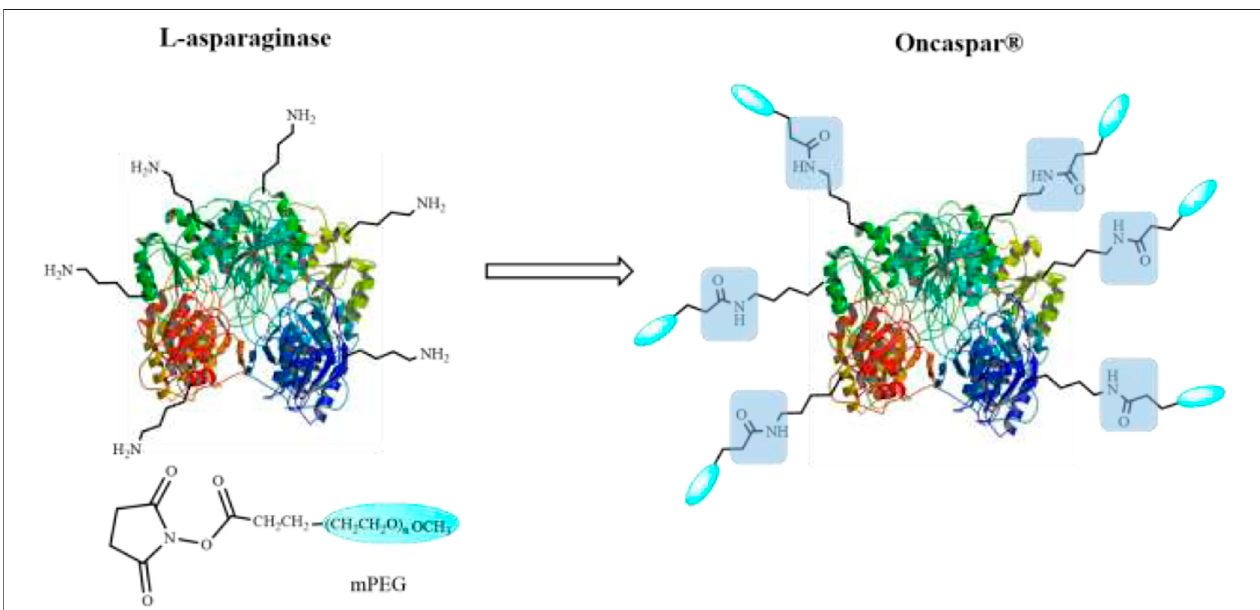
FIGURE 6 | Pegylation of L-asparaginase to obtain a nanotherapeutic product Oncaspar ® .